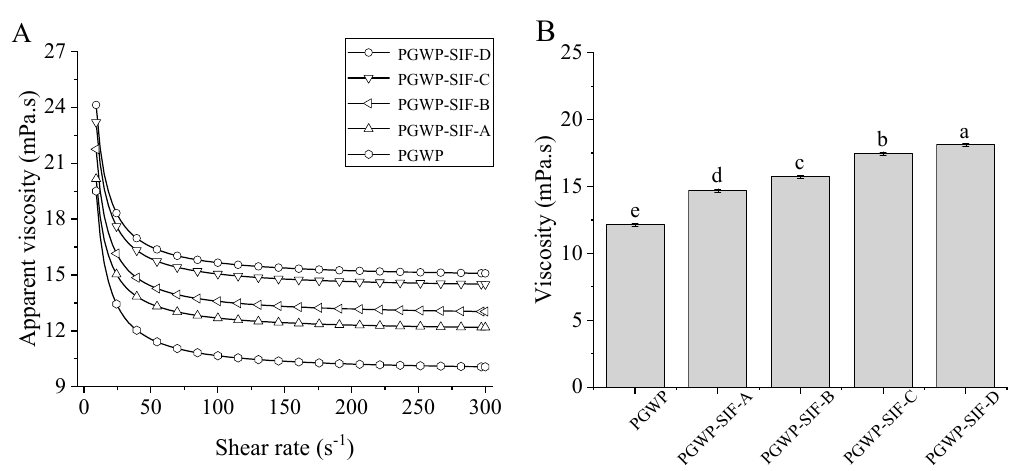
Figure 3. Effects of the SIF contents on flow behavior ( A ) and viscosity at 200 s − 1 ( B ) of PGWP-SIF. Different subscript letters indicate a significant difference ( P < 0.05). Error bars represent standard deviation of the means.